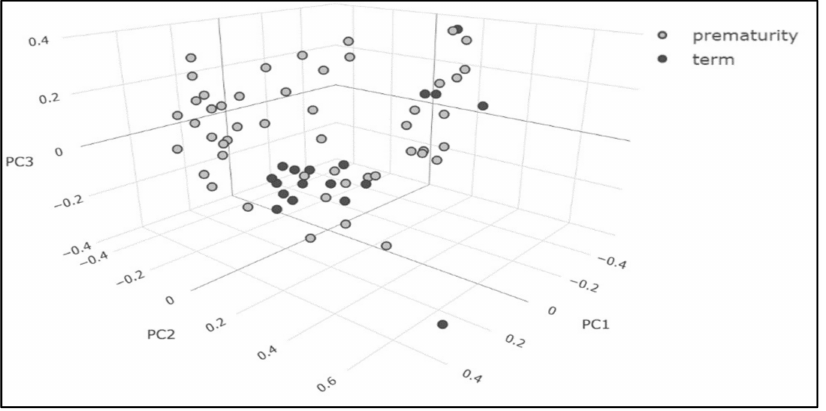
Figure 2. PCA score plot of the first three principal components; the two classes of patients, “preterm” and “term”, are represented in light gray and black points, respectively; PC: principal component.